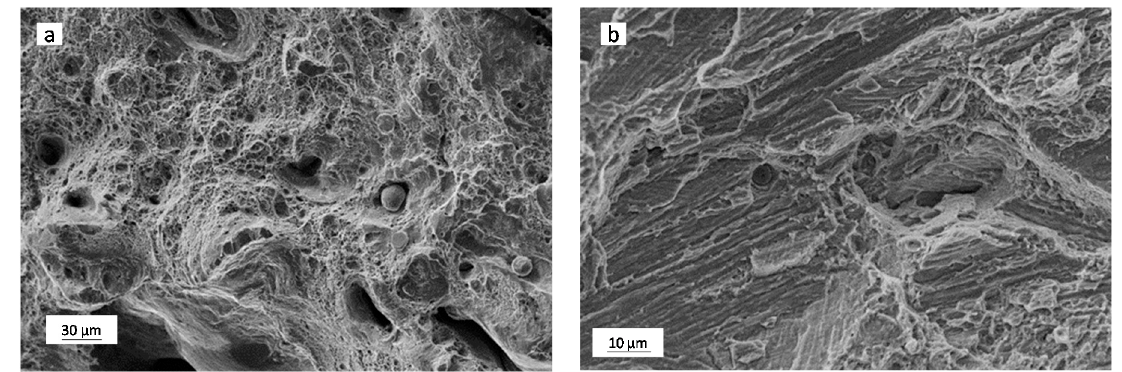
Figure 11. Fracture surfaces of broken tensile specimens: ( a ) as-built sample; and ( b ) 460 ◦ C peak-aged sample.